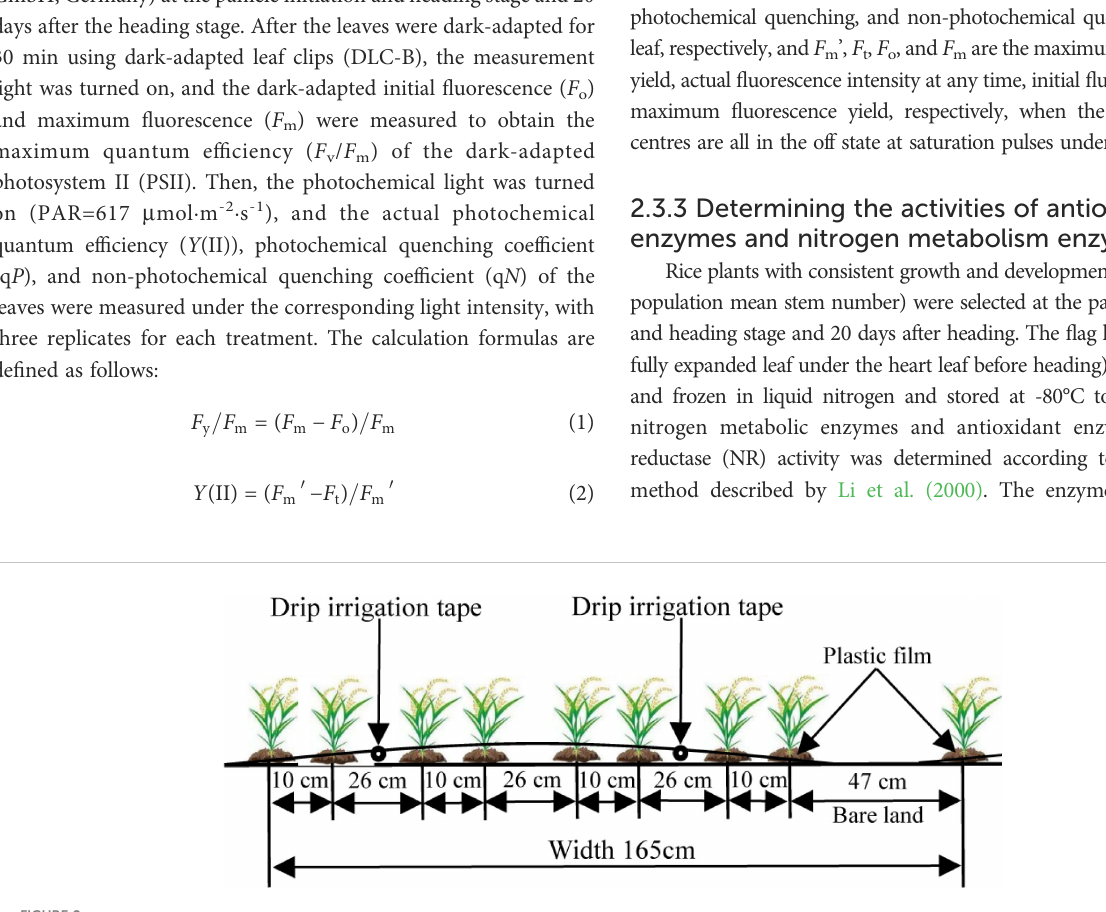
FIGURE 2 Planting mode for drip irrigation under plastic fi lm mulching.